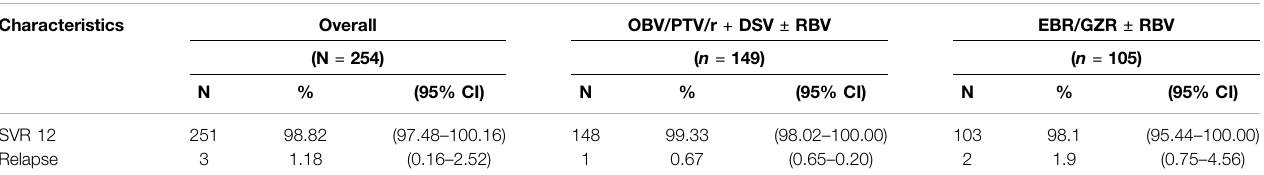
TABLE 2 | Virological response. Characteristics